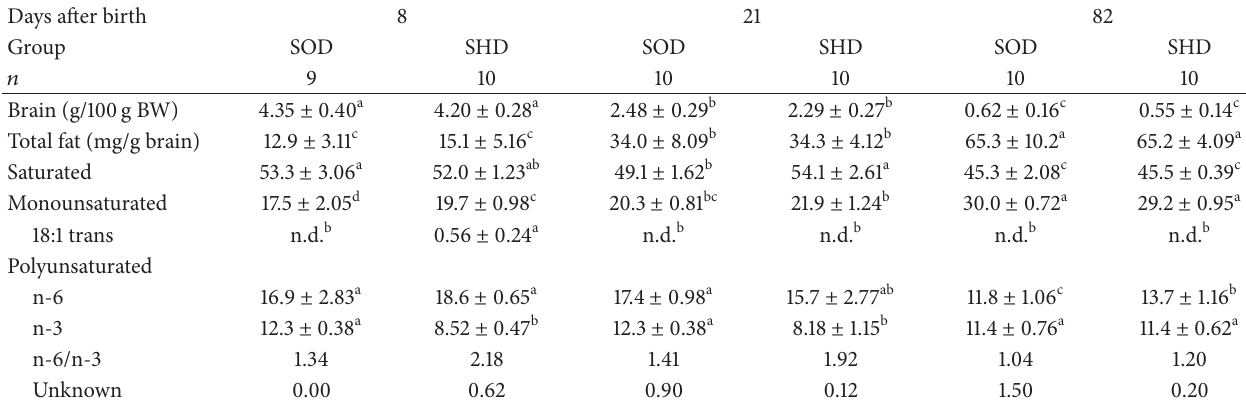
Table 8: Fatty acid composition of brains of pups, on days 8 and 21 after birth, nursed by dams fed the soybean oil or shortening diet. Days after